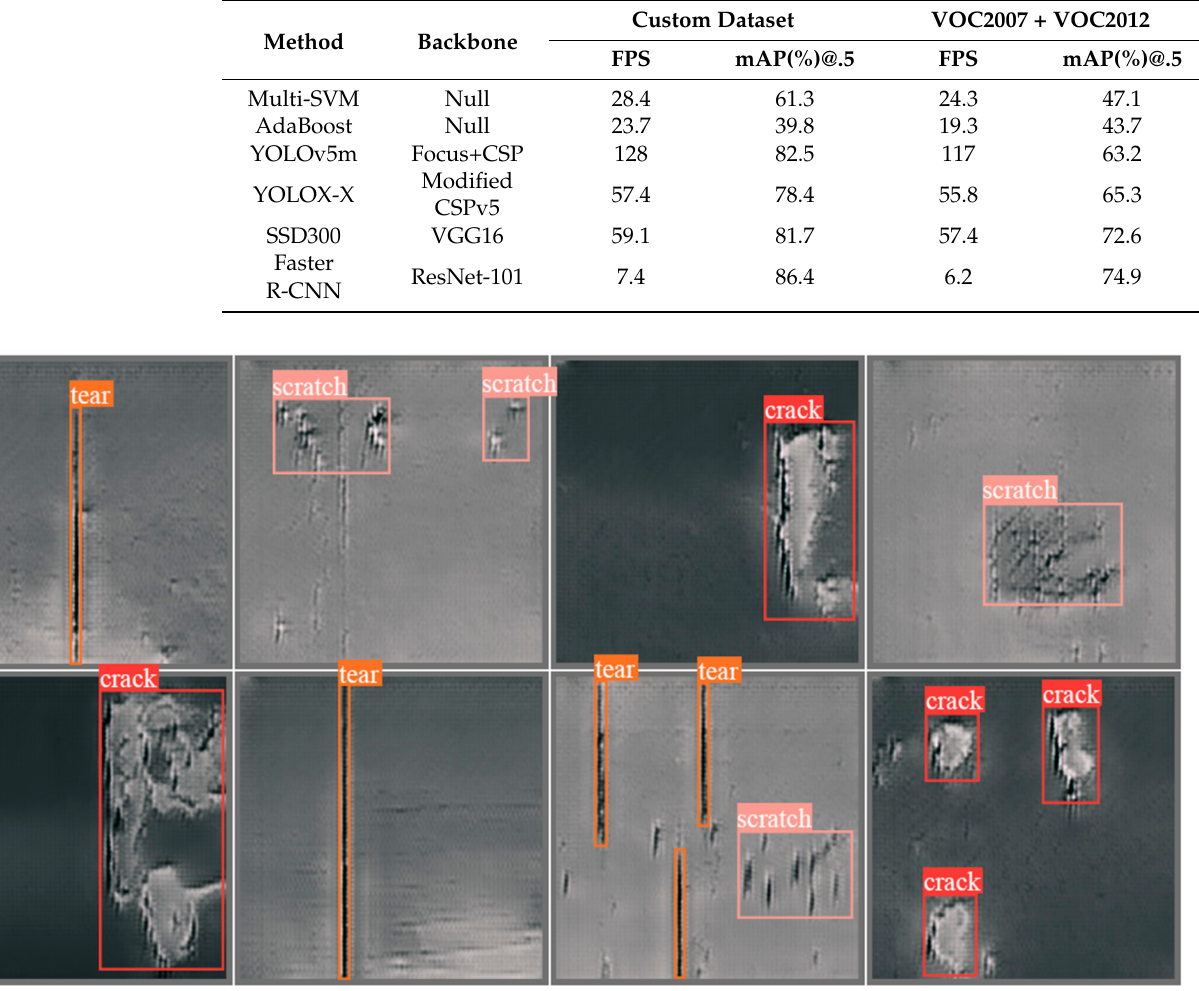
Figure 10. Visualization results contain anchor boxes and labels, showing that the obvious damage regions can be successfully detected. However, some small or inconspicuous damage regions are missed by detection